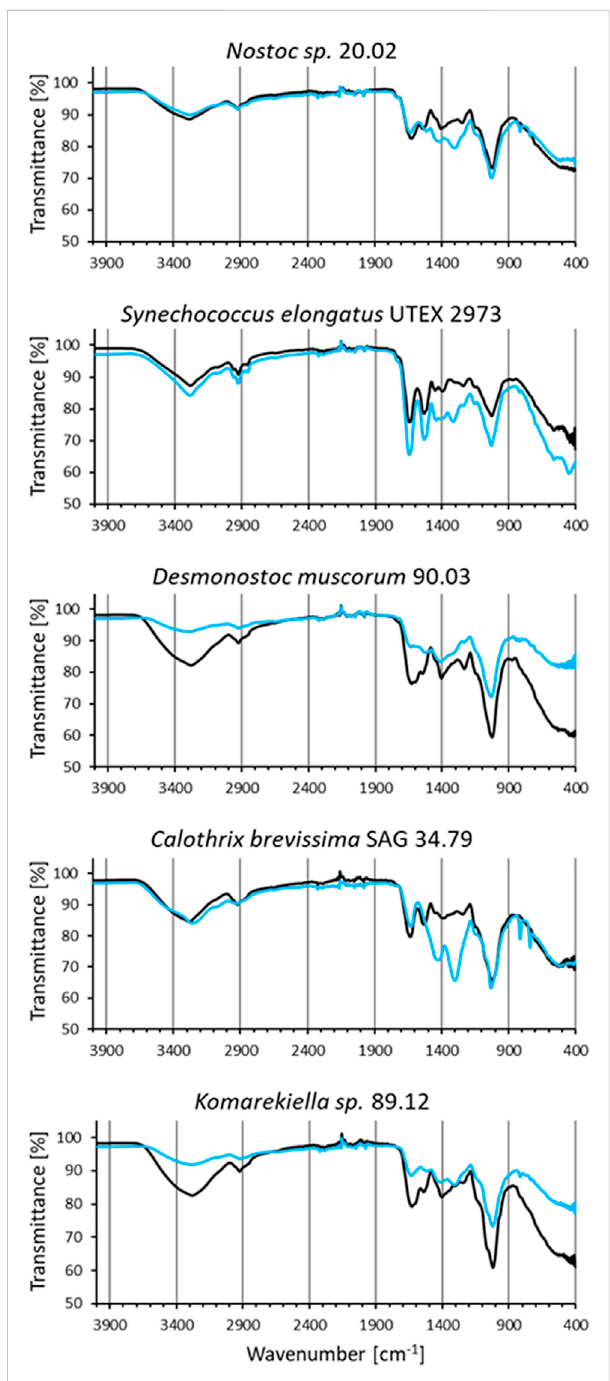
FIGURE 7 FT-IR spectra of biomass samples before (black) and